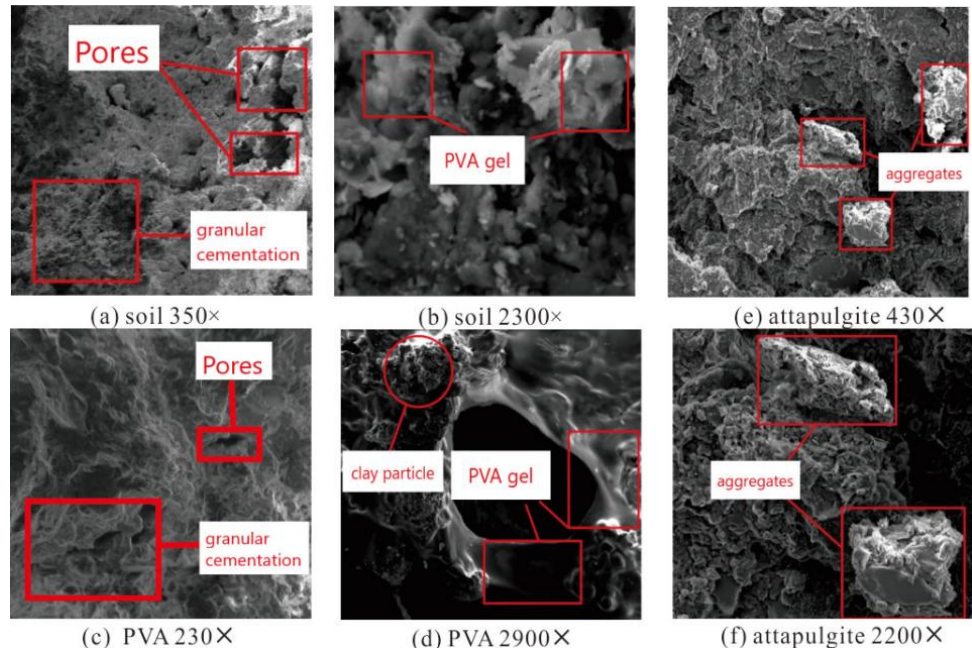
Figure 13. SEM image: ( a ) 350 times magnification of soil; ( b ) 2300 times magnification of soil; ( c ) 230 times magnification of PVA composite sample; ( d ) 2900 times magnification of PVA composite sample; ( e ) 430 times magnification of attapulgite composite sample; ( f ) 2200 times magnification of attapulgite composite sample.